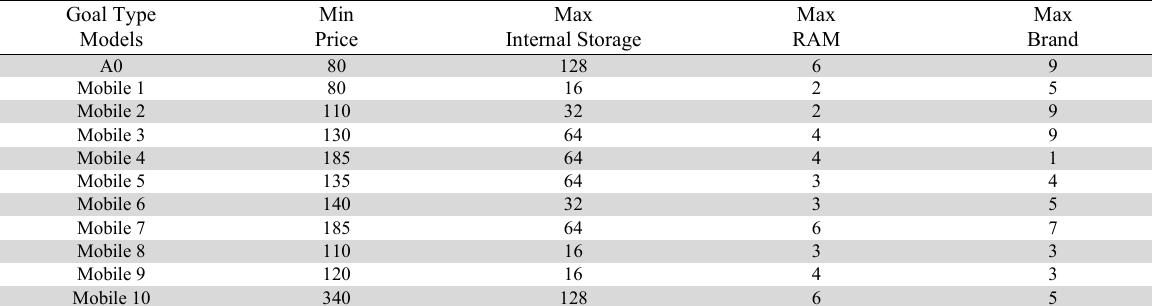
Decision Matrix